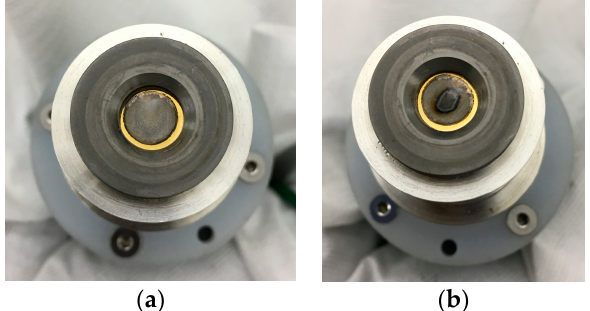
Figure 7. ( a ) 64 Ni on Au before irradiation of the 3D-printed SS925 solid target holder; ( b ) 64 Ni on Au after all irradiations as described above, and shown in Table 3.